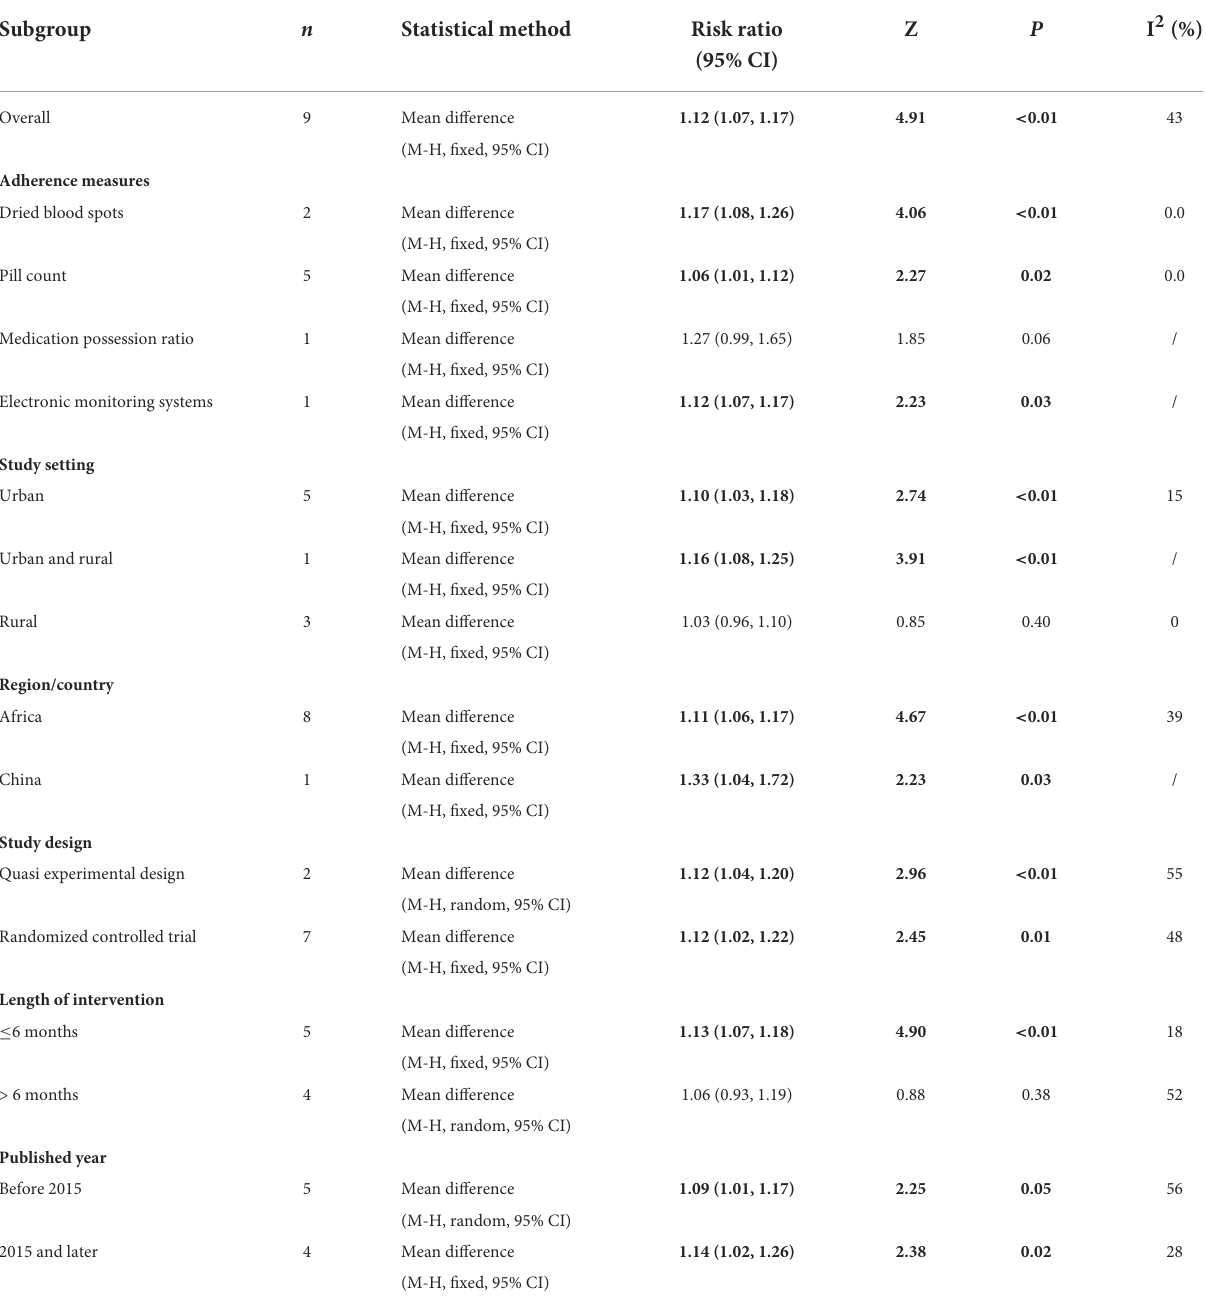
TABLE 3 Subgroup analyses by study characteristics.